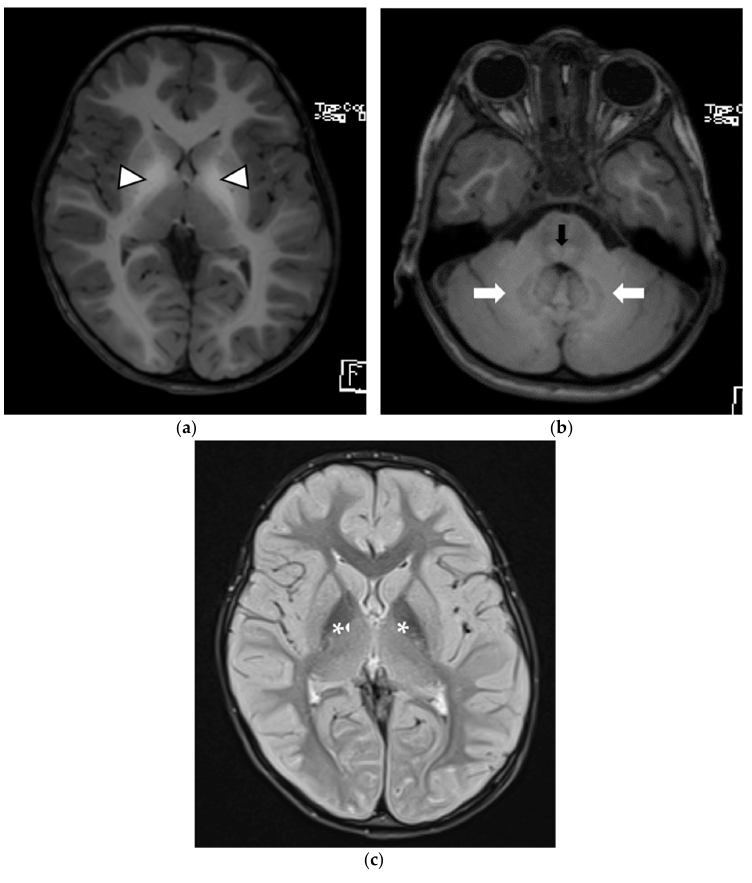
Figure 3. Patient 3 Figure 3. Patient 3.